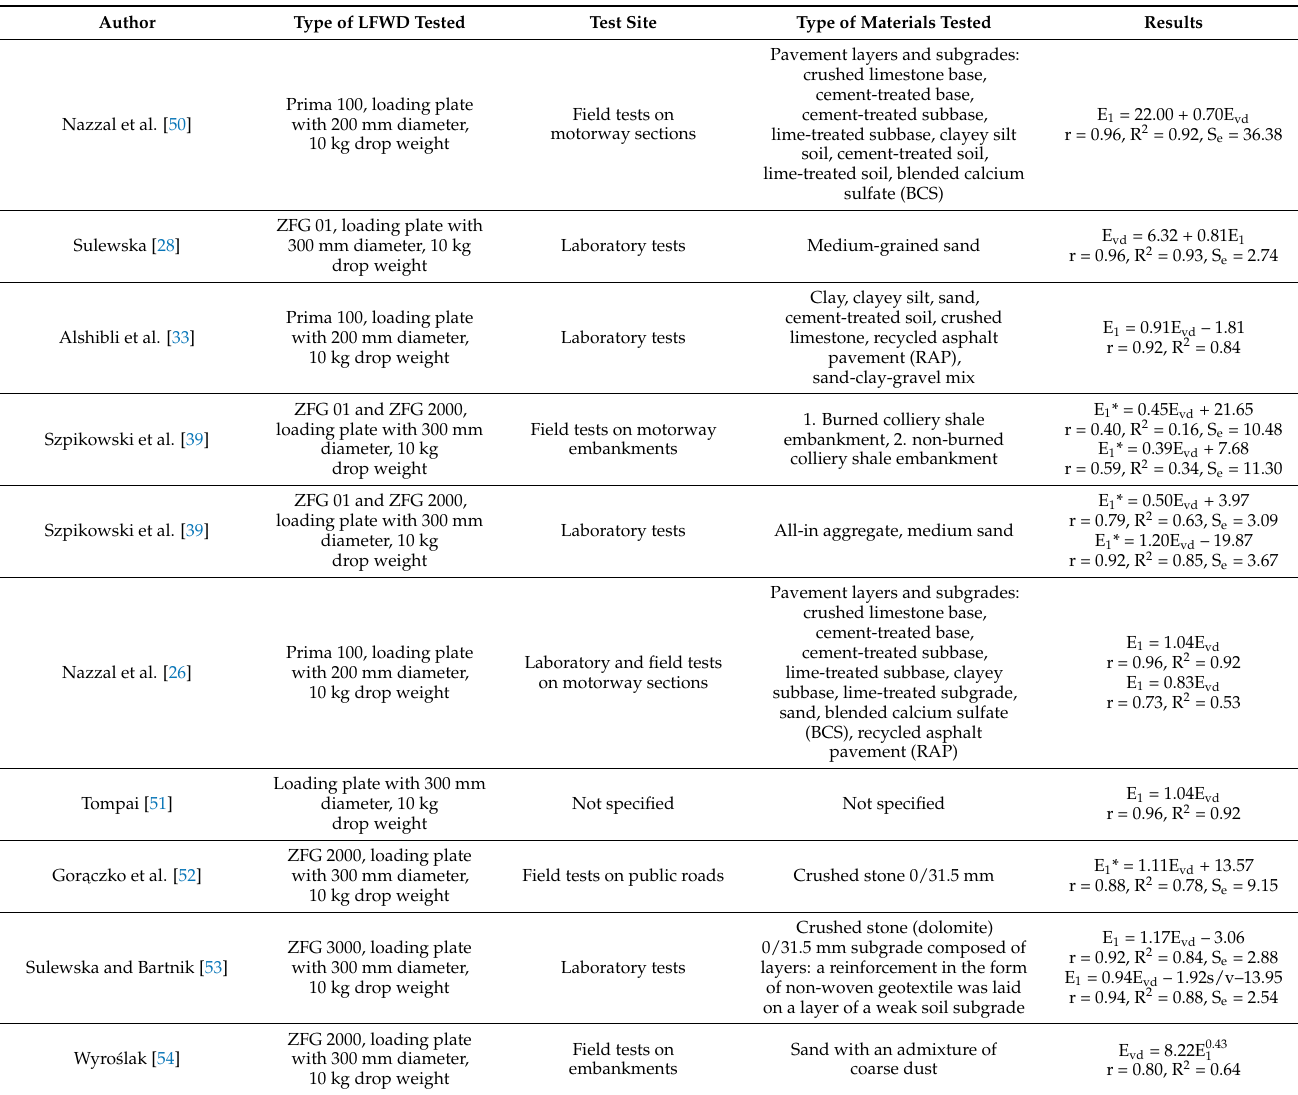
Table 1. Selected results of comparative studies of the dynamic deformation modulus E vd (LFWD), and the primary deformation modulus E 1